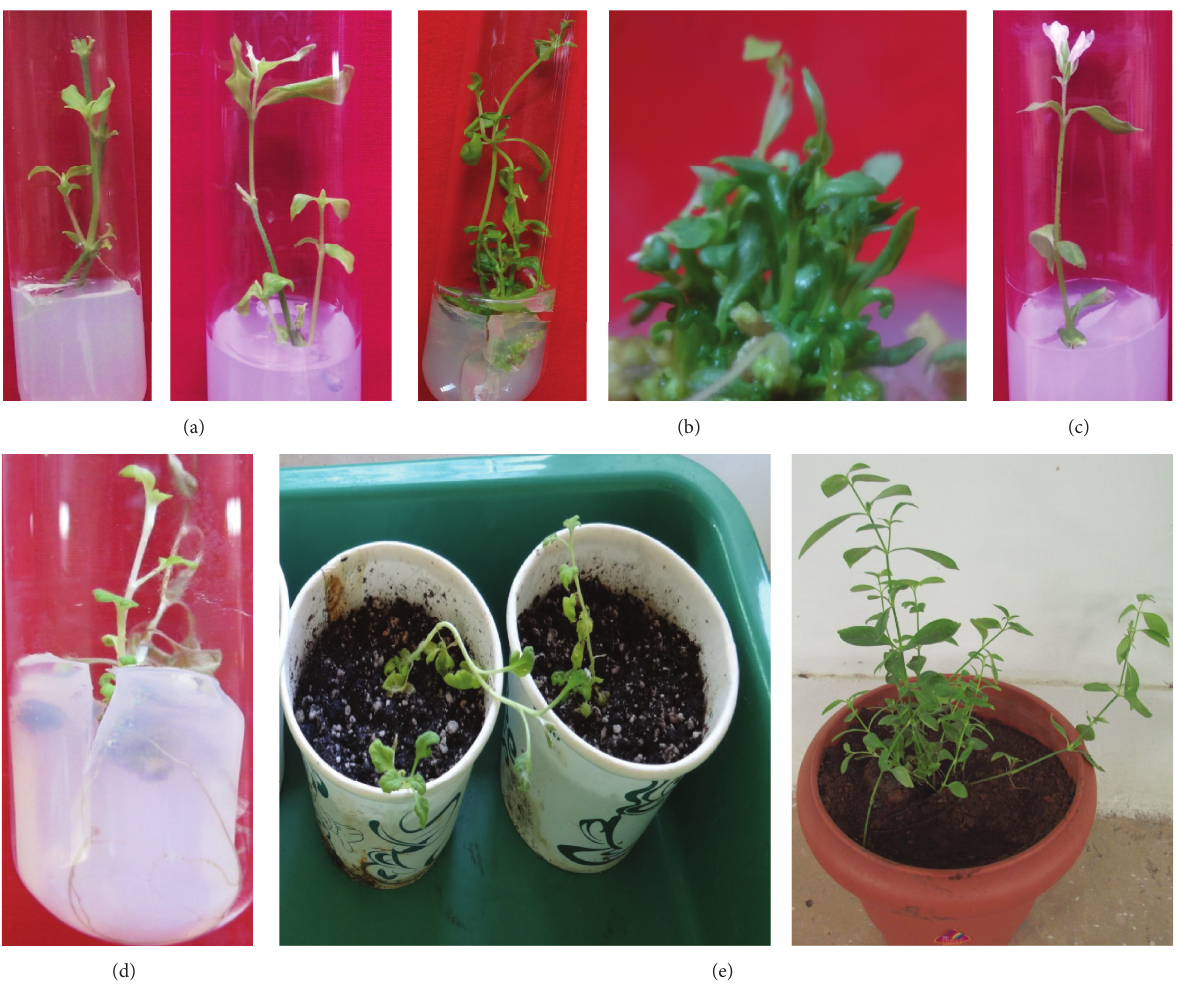
Figure 1: (a) Induction of shoots from the nodal meristems of the explants. (b) Multiplication of shoots of R. pectinata . (c) In vitro flowering in R. pectinata . (d) Induction of roots from the in vitro regenerated shoots in half strength MS medium with IBA. (e) Stages in hardening of plantlets in the greenhouse.